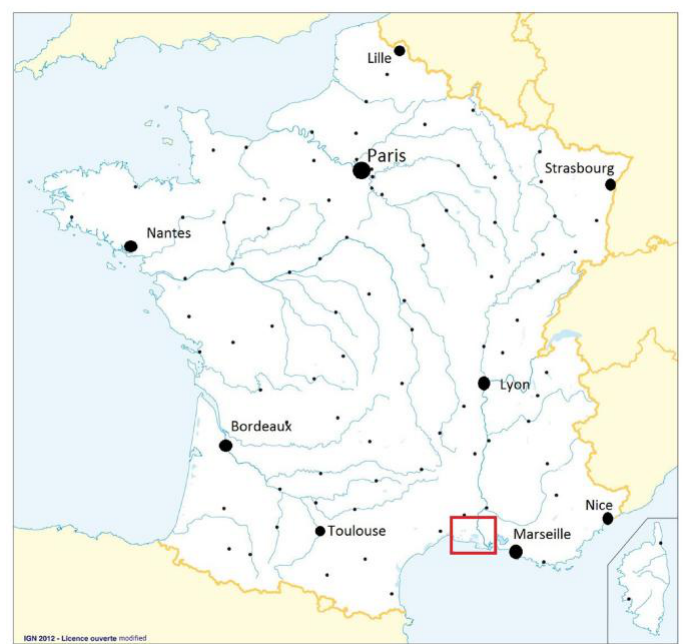
Figure 1. Localization of the study area in France (in the red